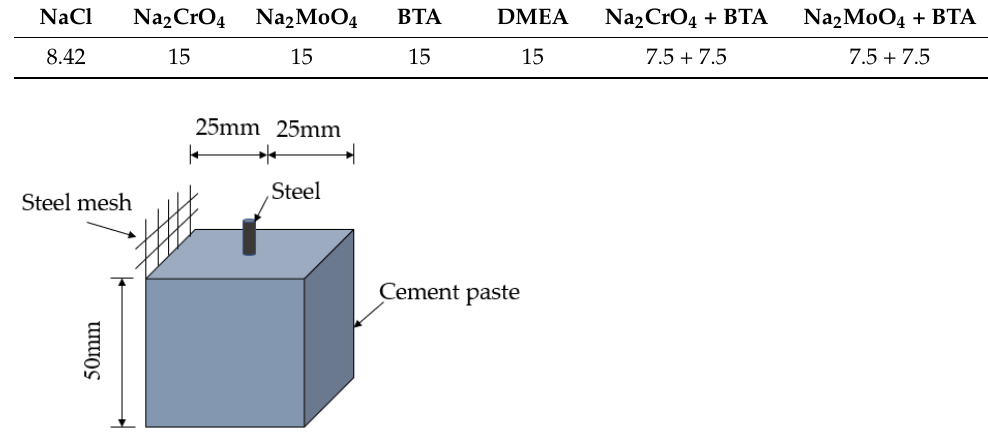
Figure 1. Schematic diagram of the electrochemical specimen.